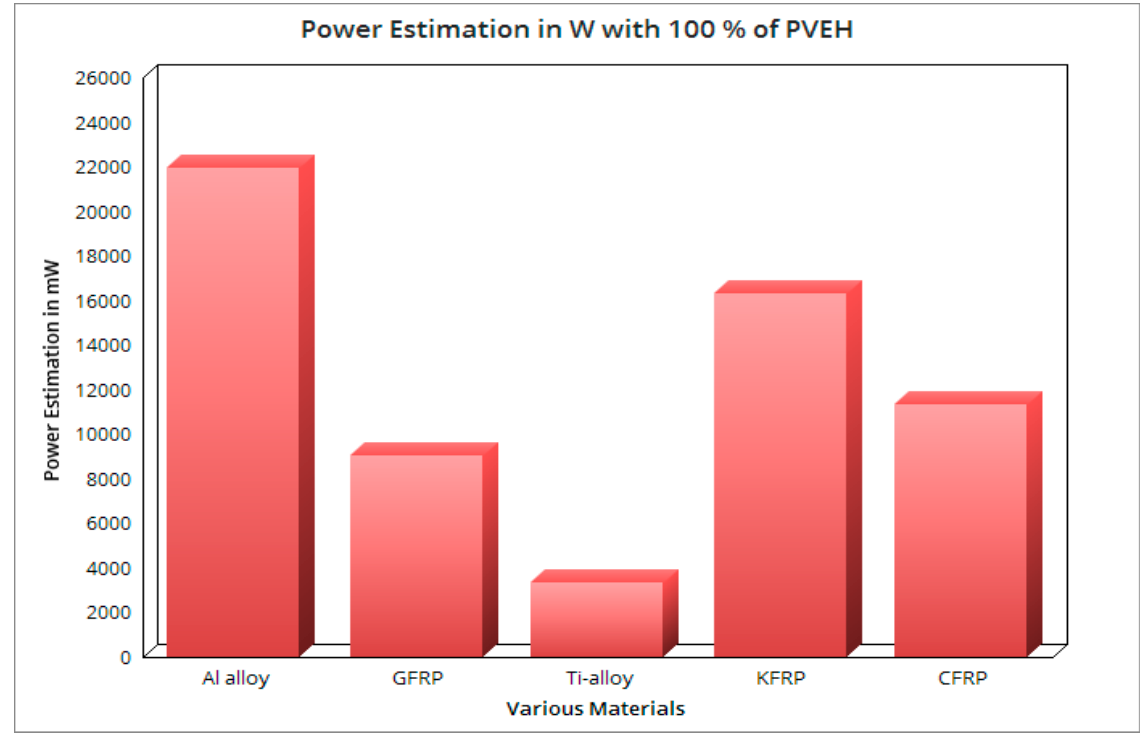
Figure 39. A typical view of a UAV wing with piezoelectric patch.